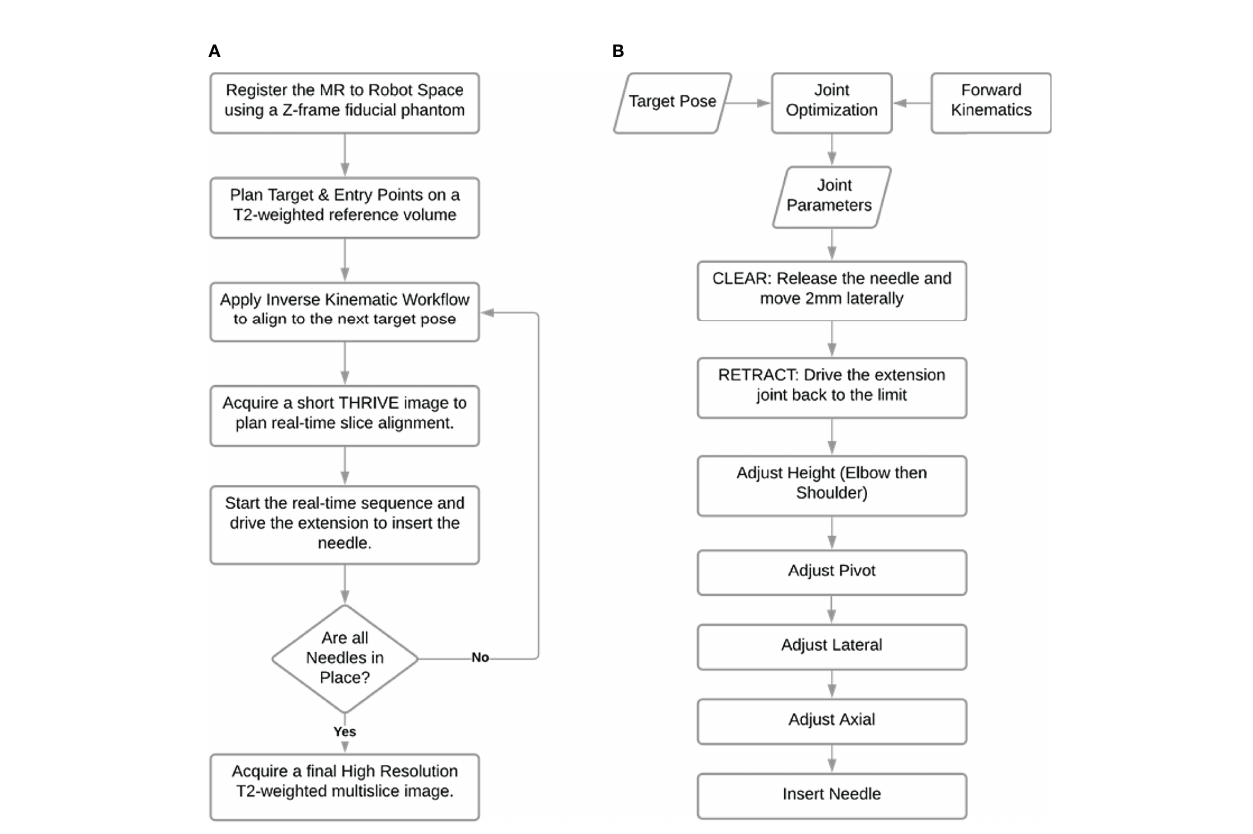
FIGURE 3 | Work fl ow of needle insertions. (A) Procedure work fl ow; (B) Single needle insertion inverse kinematic work fl ow represented by third step in work fl ow (A)